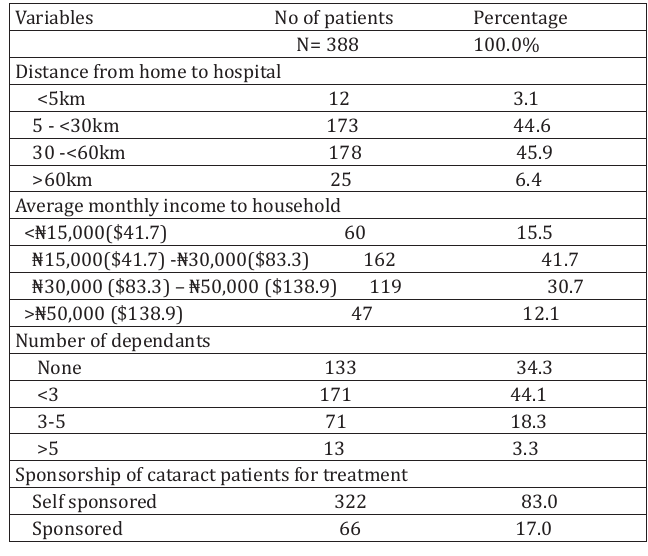
Socio-economic factors of the 388 cataract